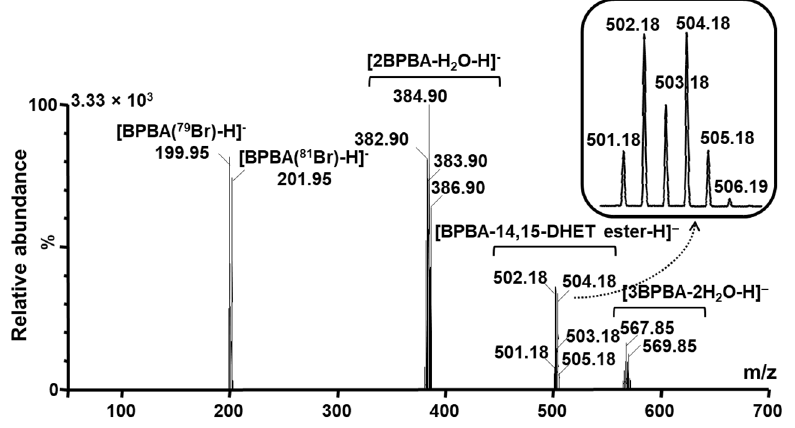
Figure 1. Full scan mass spectrum of the BPBA labeled 14,15-DiHETrE using Micromass LCT in negative ion mode.